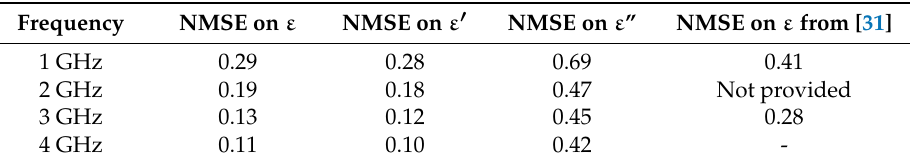
Table 2. NMSE of very dense breast (ID 012304). Table 1. NMSE of heterogeneously dense breast (ID 062204).